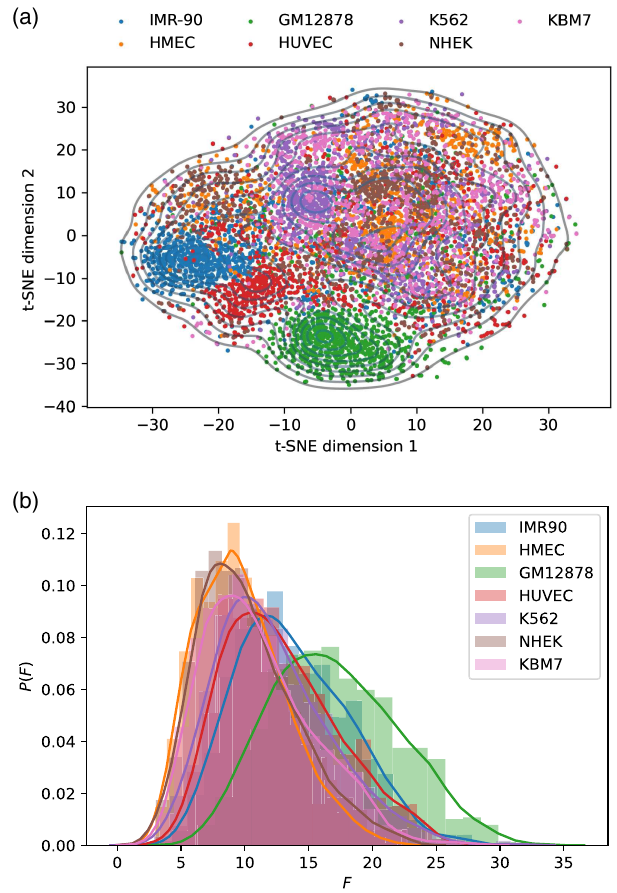
FIG. 7. (a) t-SNE plot for the ensemble of chromosomes 21 structures for 7 cell types (IMR-90, HMEC, GM12878, HUVEC, K562, NHEK, KBM7). We used 1000 independent conforma- tions for each cell type. A conformation is represented by the distance matrix. The metric used to compare two single chro- mosomes is the squared Euclidean norm between the distance matrices. (b) The distribution of F ð k Þ [Eq. (10)] for different cell types. We take k ¼ 8 , corresponding to 8 nearest